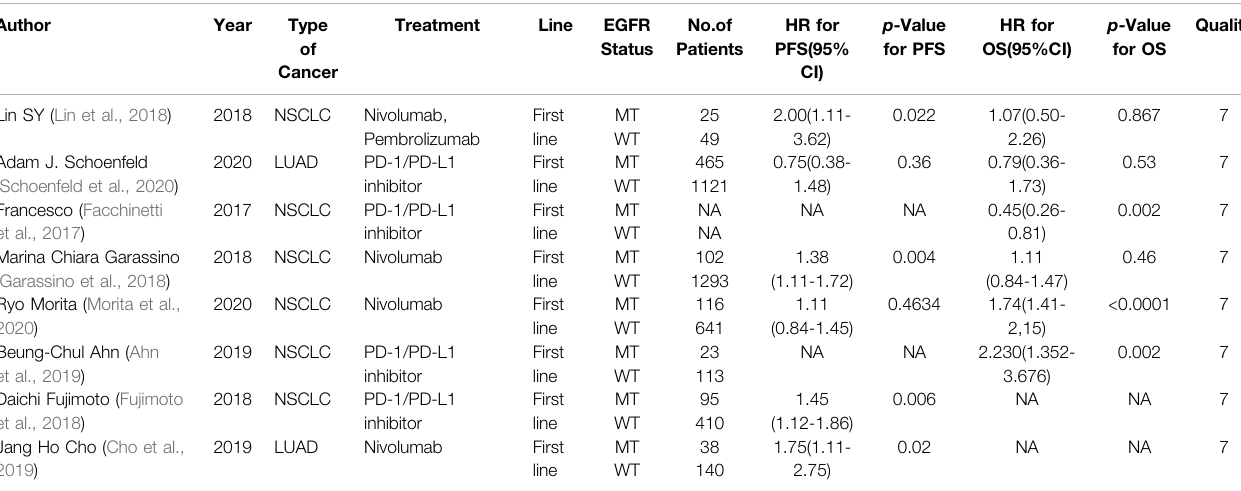
TABLE 3 | Basic characteristics of included studies with EGFR